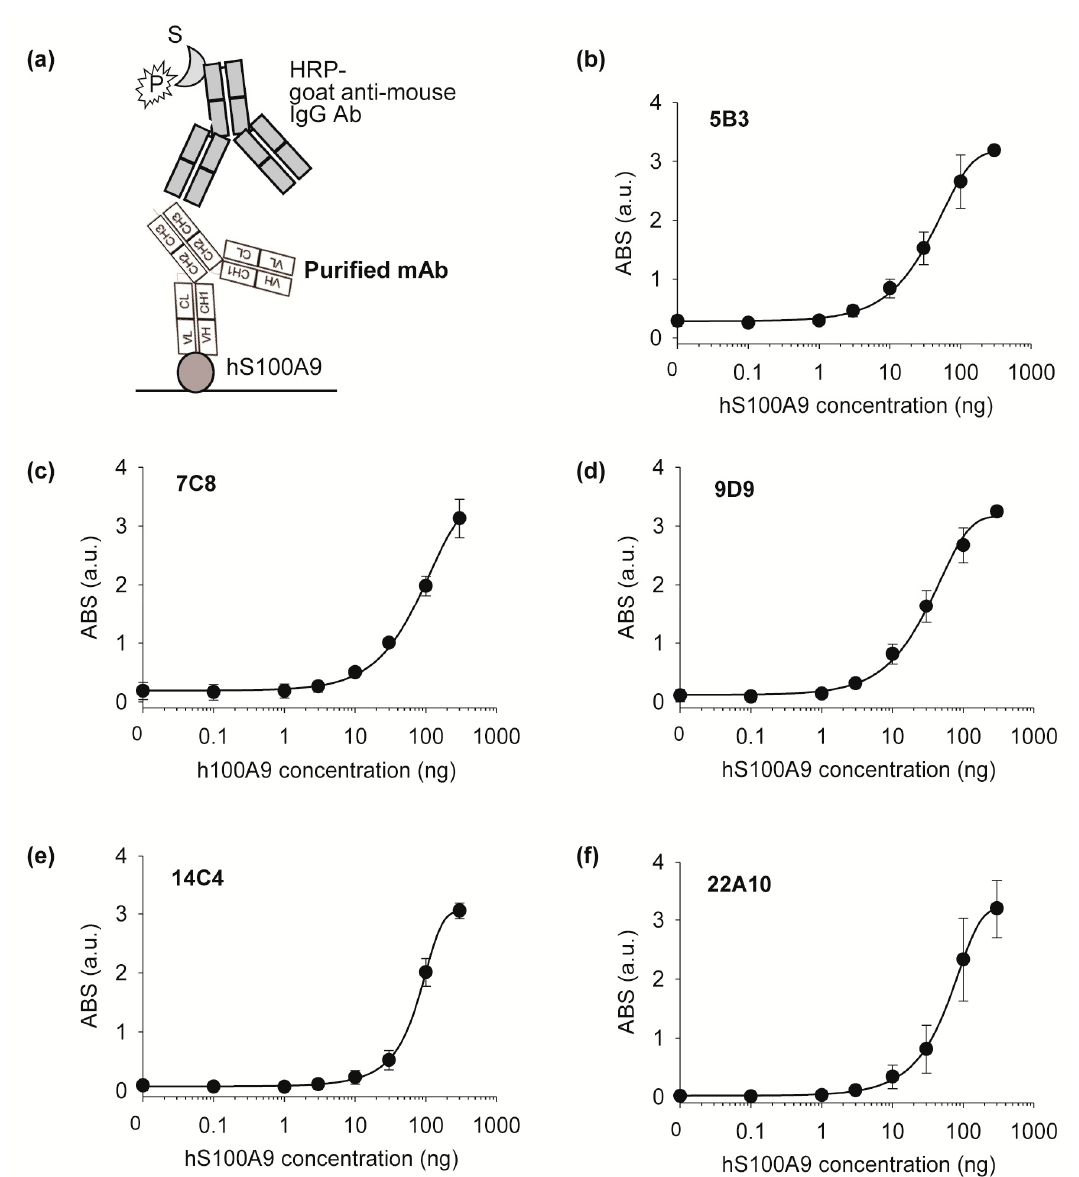
Figure 2. ( a ) Schematic representation of the indirect ELISA for confirming the dose-dependent antigen binding efficiency of selected five monoclonal antibodies. ( b – f ) ELISA signals of monoclonal antibodies with various concentrations of hS100A9. The points represent absorbances at the indicated antigen concentrations. The lines indicate dose–response curves, which were fitted to a four-parameter equation, y = a + (b − a)/(1 + (c/x)ˆd), using GraphPad Prism software, where a, b, c, and d indicate ABS in the absence of antigen, ABS in the presence of 300 ng antigen, EC50, and hill slope, respectively. The EC50 values were estimated based on the parameter c in the formula. The LOD was obtained as the estimated antigen concentration that shows the mean blank value +3 SD. SD = standard deviation. Table 1. Absorbance values of monoclonal antibodies with 300 ng of rhS100A9, EC 50 of the antibodies, and limit of detec- tion (LOD) values of the assay.